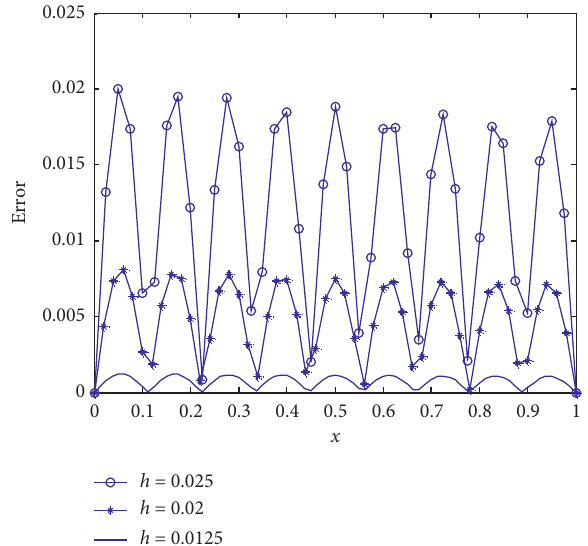
Figure 8: The point-wise absolute errors of Example 4 for different values of mesh size h , ε � 2 − 8 , and δ � 0 . 5 ε